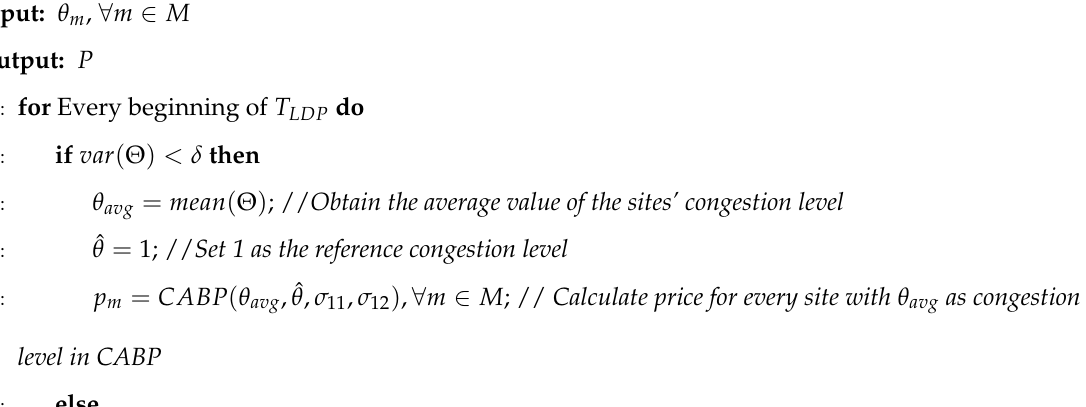
Algorithm 2 The LDP